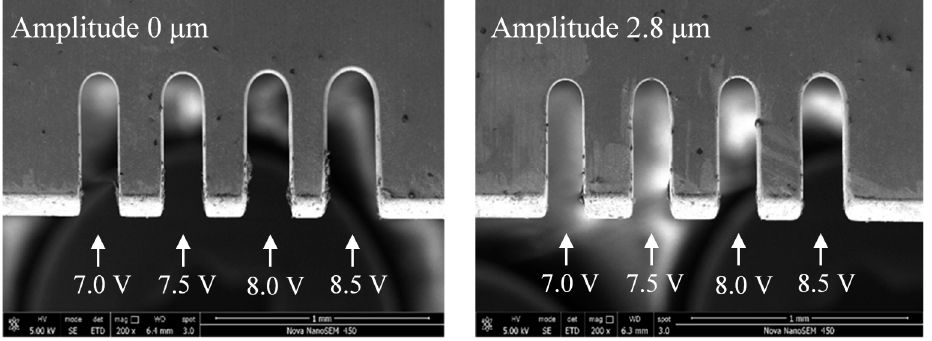
Figure 14. Microslits under different voltages.